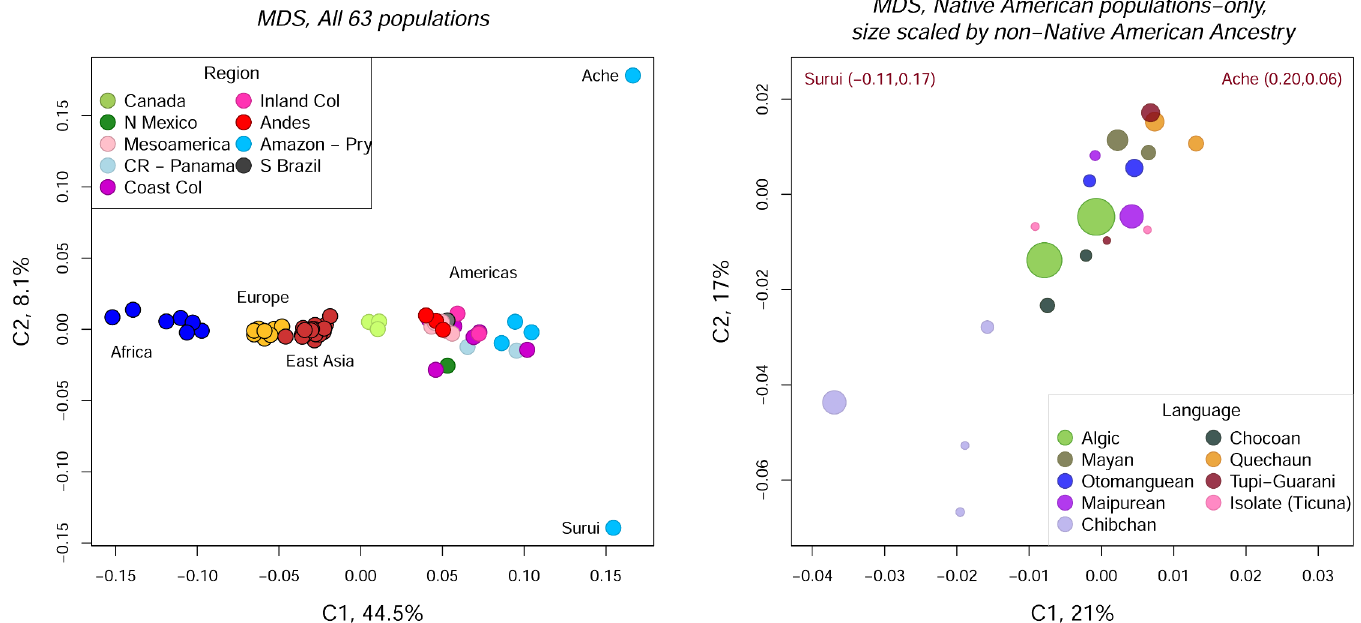
Fig 8. MDS plots of Nei ’ s minimum genetic distances. A. All 63 populations, color-coded by geographic region. B. 29 Native American populations only, color-coded by language family and sized by the level of non-Native American ancestry. The Tupi-Guaraní-speaking Ache and Suruí populations fall well outside of the plot margins. Their PCo scores are shown in the upper right and left portions of the